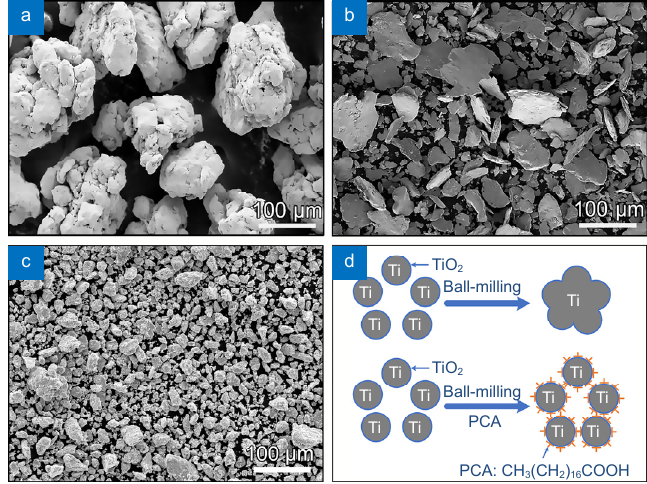
Fig. 3 | Powder morphology variation using different amount of PCA, ( a ) 0 wt.%, ( b ) 1 wt.% and ( c ) 0.2 wt.%, and ( d ) schematic graph to show the effect of PCA on the powder modification. The original TiO 2 film on top of powder surface may get resolved into Ti matrix during SLM